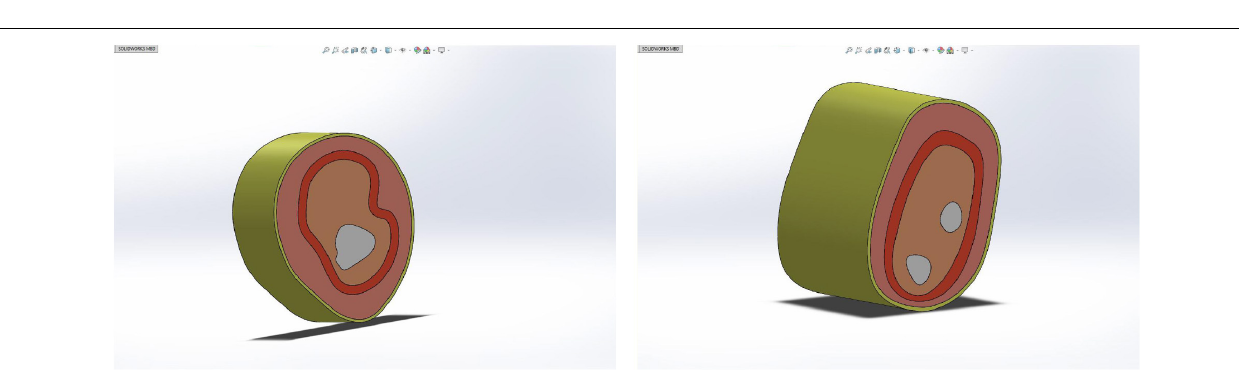
FIGURE 6 | Reconstructed model of upper